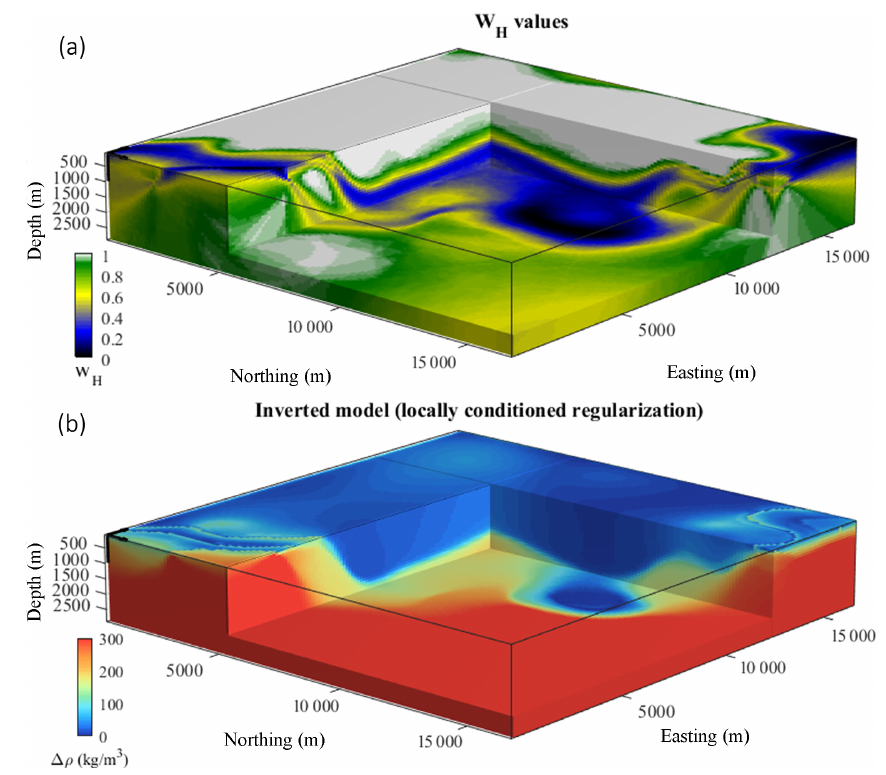
Figure 5. (a) Local weights W H calculated from a PGM, corresponding to exaggerated uncertainty in geological input measurements and (b) corresponding inverted density contrast